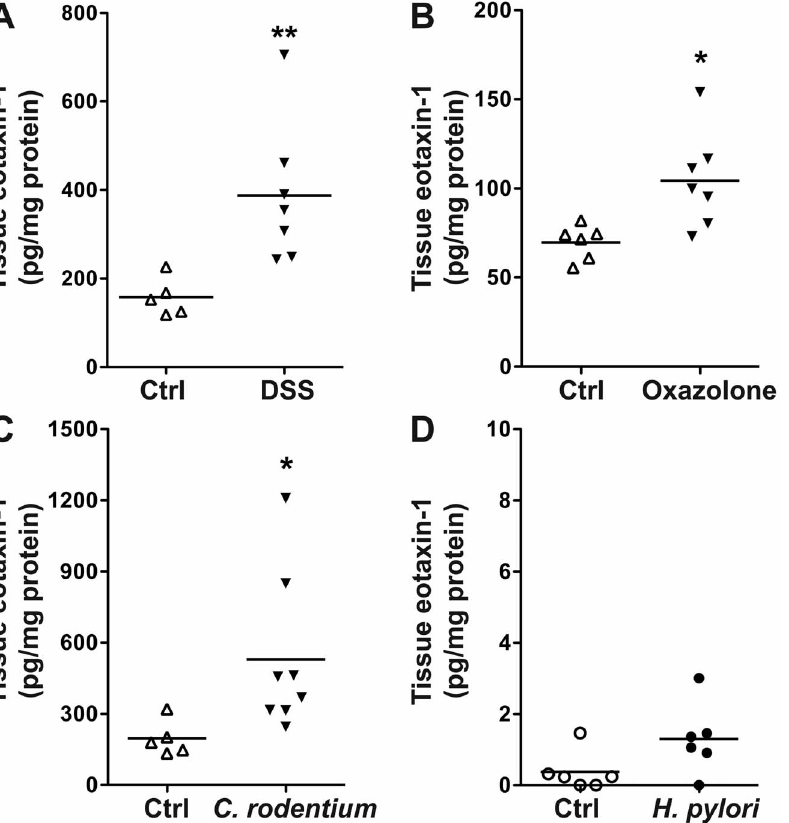
Figure 7. Colonic tissue eotaxin-1 levels are increased in mouse models of colitis but not in H.pylori -induced gastritis. Tissue samples were obtained at the time of sacrifice, placed in RIPA buffer, then lysed. Eotaxin-1 levels were assessed by Luminex assay. Each sample was corrected for tissue lysate protein concentration. Tissues were obtained as follows: (A) After 7 days of 4% DSS in the drinking water. (B) 3 days after intrarectal exposure to oxazolone. (C) 14 days after initiation of C. rodentium infection. (D) 4 months after inoculation with H. pylori . * p , 0.05; ** p , 0.01 vs. control. Table S2 Tissue eotaxin-1 levels in UC patients based on medication use. Tissue samples were obtained and assessed by Luminex as in Figure 2. UC patients were categorized by medication use at the time of tissue collection.